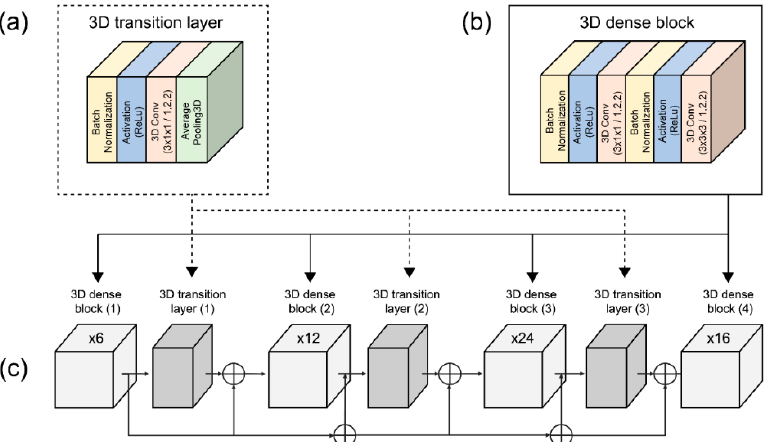
Figure 5. 3D dense connection CNN architecture. ( a ) 3D transition layer structure; ( b ) 3D dense block structure; ( c ) detailed 3D dense connection CNN.